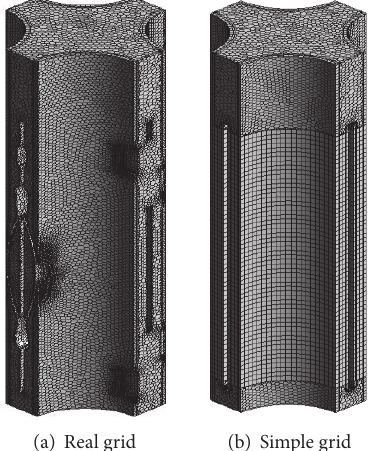
Figure 25: Mesh for structure research.